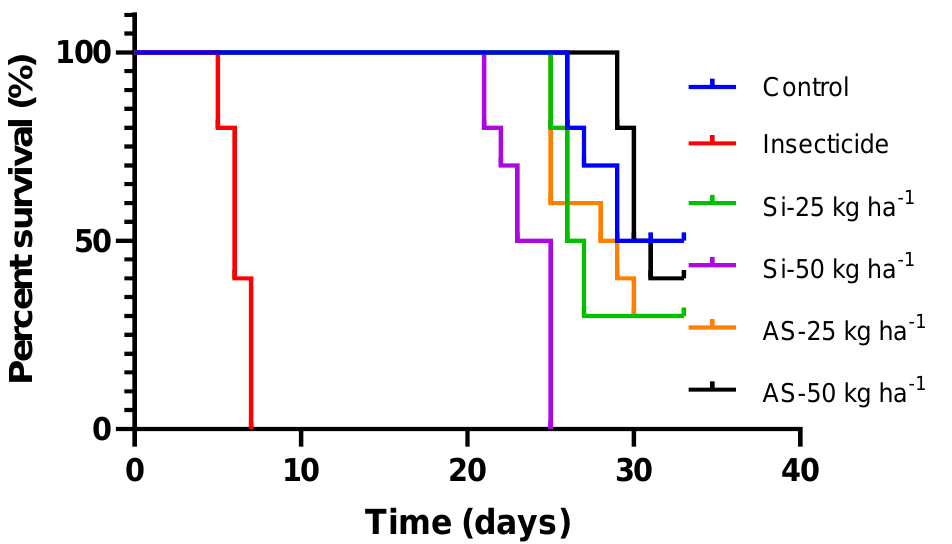
Figure 3. Kaplan–Meier survival functions of Brevicoryne brassicae under nutrient deterrence treat- ments of Si (Silicon) and AS (Ammonium Sulfate) (Mantel-Cox test, p < 0.0001).